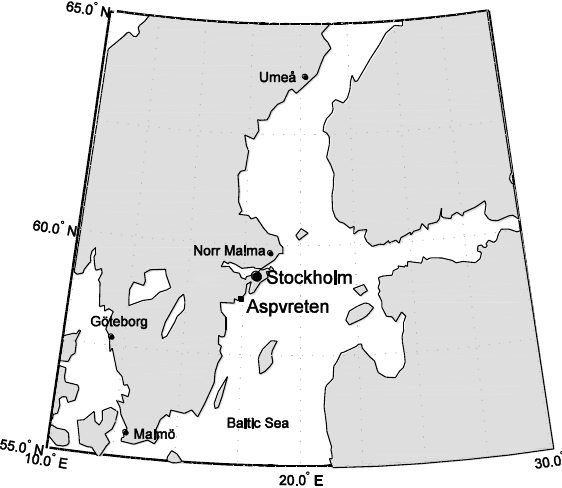
Fig. 1. Location of Stockholm city, Aspvreten and Norr Malma Fig. 1 rural background